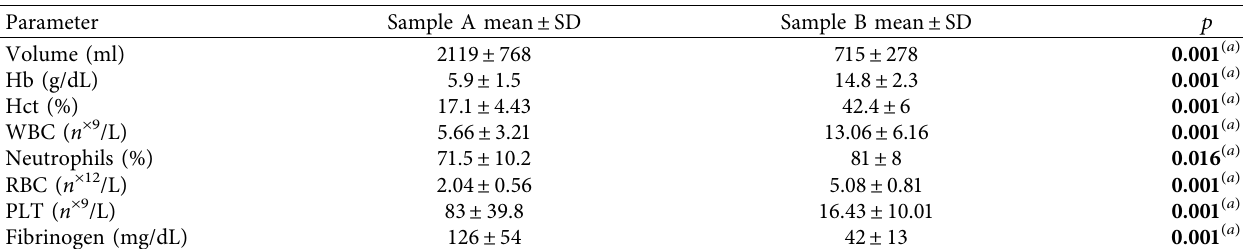
Fibrinogen (mg/dL) The bold values indicate significantly different at p <